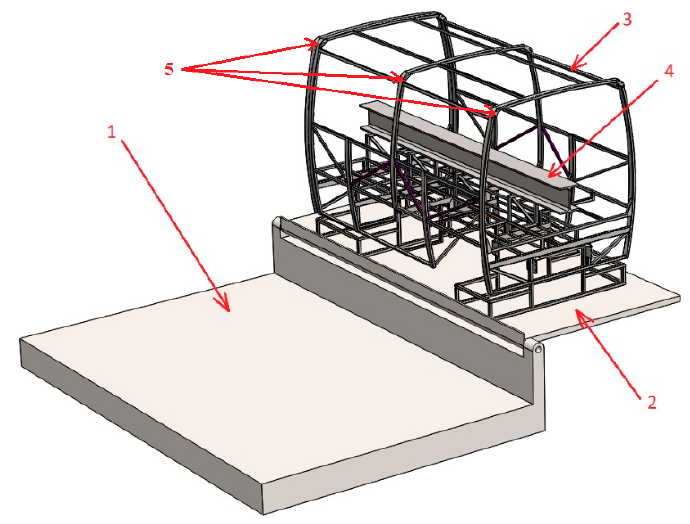
Figure 4. The computational model of a rollover of the safety frame: 1—concrete base, 2—tip-up platform, 3—rollover safety frame model, 4—additional weight, 5—sensors for contact detection.